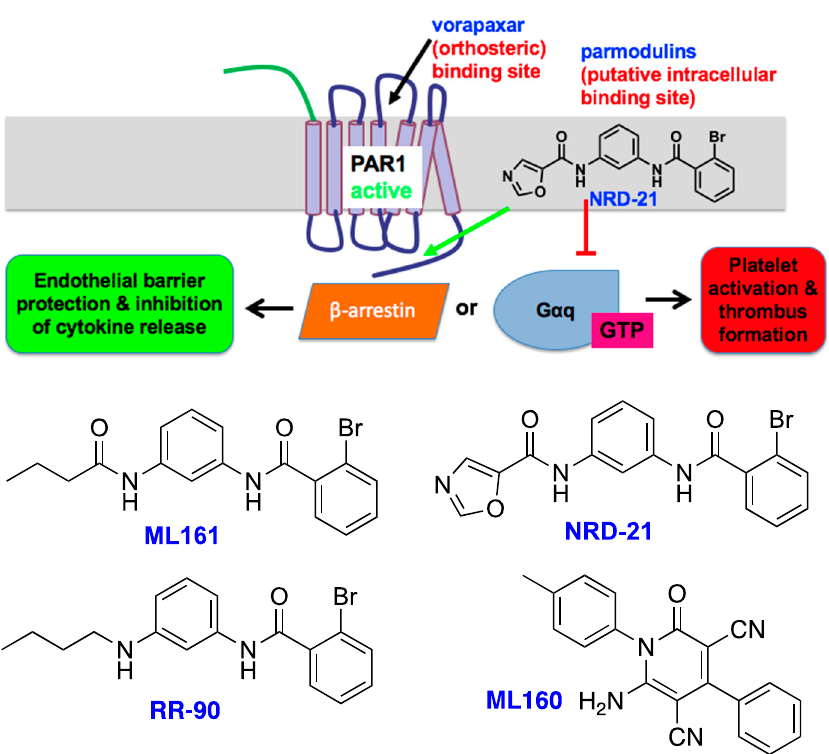
Figure 8. Top: Simplified parmodulin mode-of-action diagram. Inflammatory signaling (typically driven by α -thrombin) at PAR1 can be blocked by parmodulins, which bind to a putative intracellular site. Anti-inflammatory signaling of PAR1, thought to be mediated by β -arrestin 2, may be permitted or promoted by parmodulins. Bottom: Several key parmodulins discovered in the Dockendorff lab.